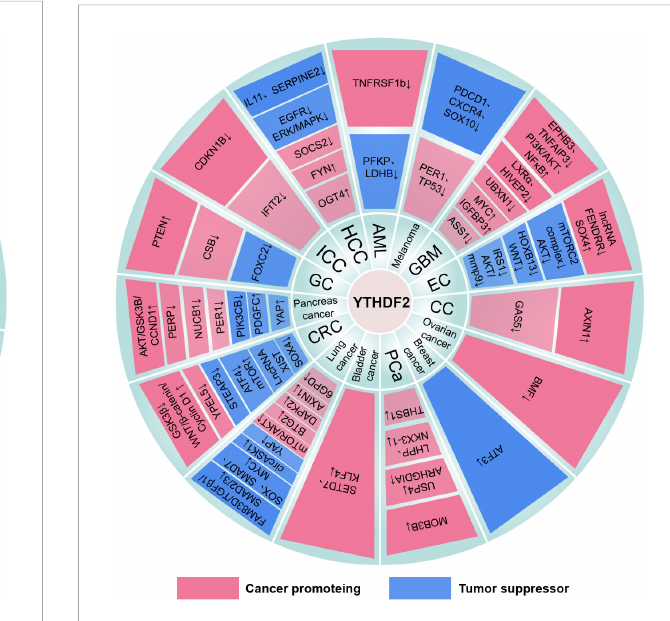
FIGURE 5 The mechanism of the YTHDF2 family in cancers. “ ↓ ” is the decrease of target mRNAs. “ ↑ ” is the increase of target